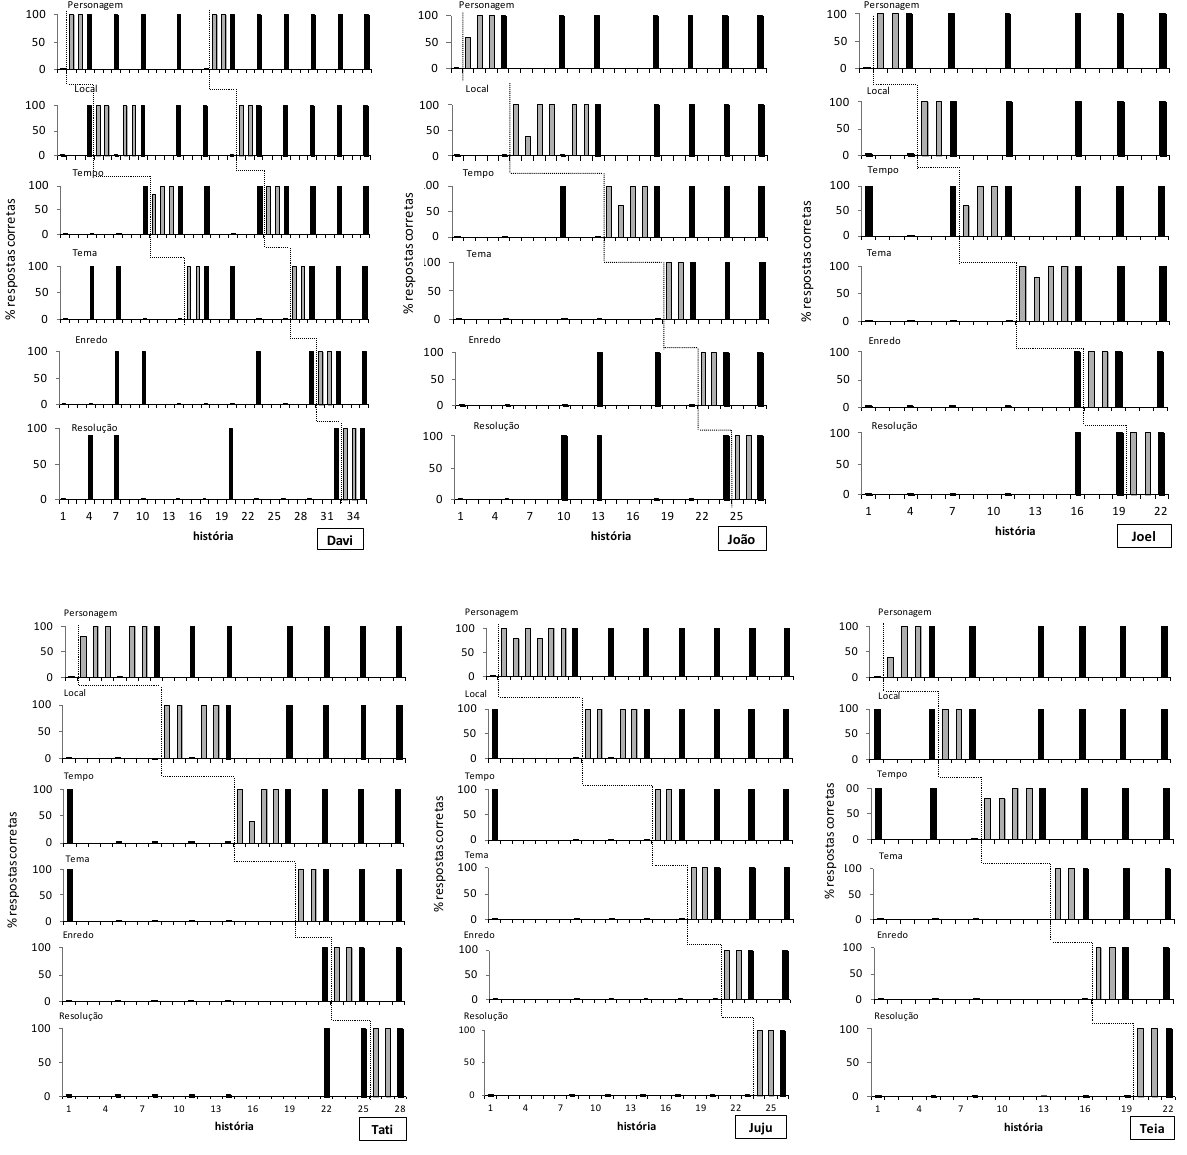
Figura 1. Porcentagens de Respostas Corretas por História, Durante o Ensino (Barras Cinzas) e nos Pré e Pós-Testes de Identi fi cação (Barras Pretas) das Categorias Estruturais de História dos Participantes do Estudo